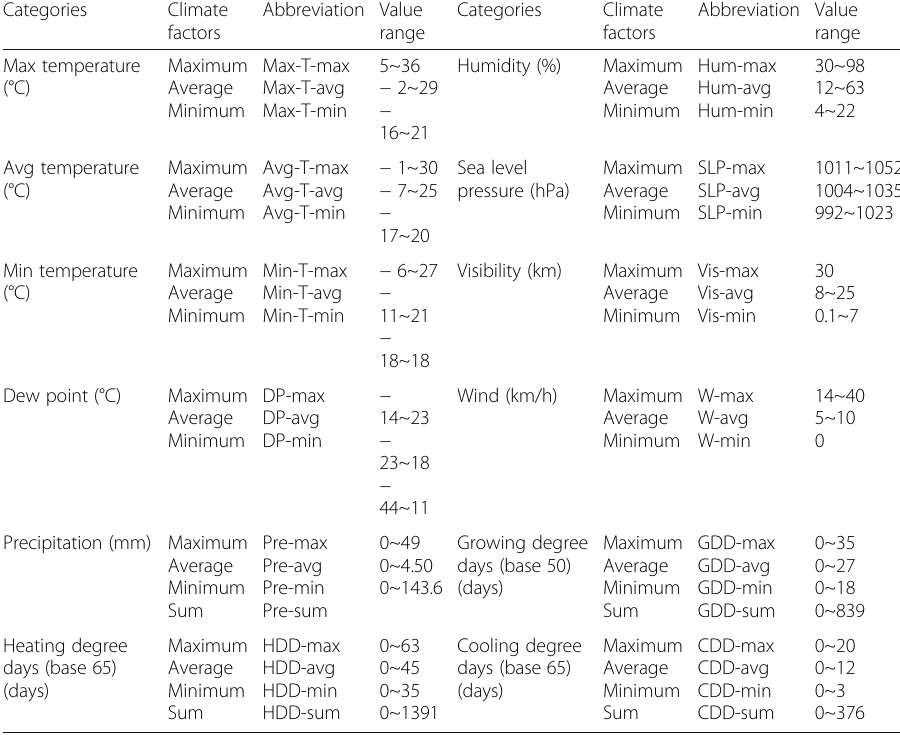
Table 2 The categories of the input